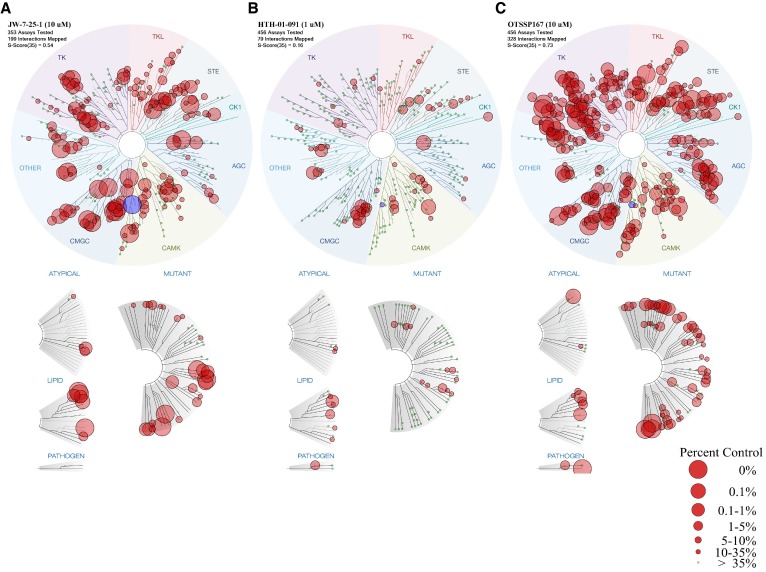
KINOMEscan TREEspot analysis of MELK inhibitors.(A) Kinase profile of JW-7-25-1 at 10 μM (KINOMEscan, 353 kinases). (B) Kinase profile of HTH-01-091 at 1 μM (KINOMEscan, 456 kinases). (C) Kinase profile of OTSSP167 at 10 μM (KINOMEscan, 456 kinases). The circle that represents MELK is in blue while all other bound kinases are in red. The S(35) score indicates the percentage of kinases within the panel that demonstrate <35% retention on the solid support after inhibitor treatment.